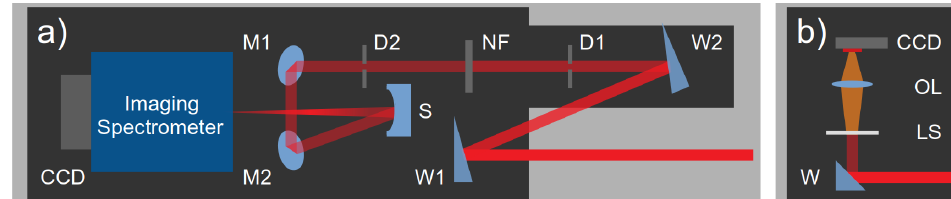
Figure 2. ( a ) The angle-wavelength spectra measurement setup scheme (W1, W2—wedges, D1, D2—diaphragms, NF—neutral filter (attenuator), M1, M2—aluminium-coated mirrors, S—spherical mirror). ( b ) The transverse fluence profile measurement setup scheme (W—wedge, LS—luminescent screen, OL—objective lens.